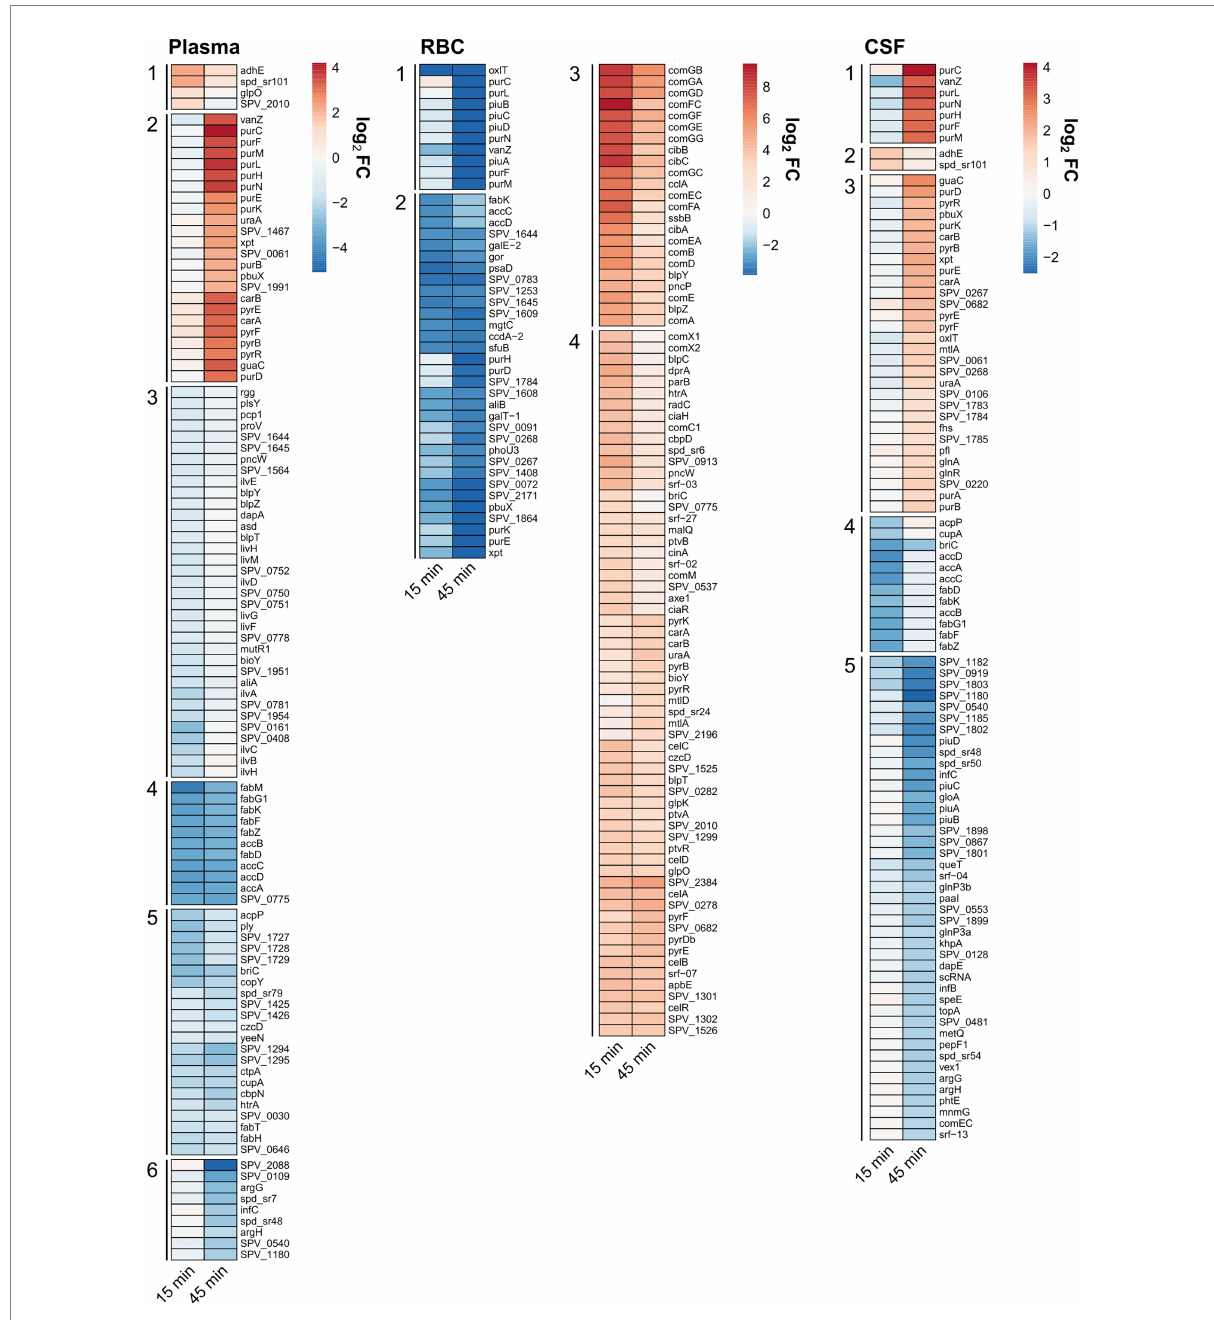
FIGURE 4 Clustered relative expression heatmaps showing the top differentially expressed genes in the different conditions: plasma, RBC and CSF cultures [FDR < 0.01, log 2 (FC) > 2 or log 2 (FC) < − 2 for plasma, log 2 (FC) > 3 or log 2 (FC) < − 3 for RBC, and log 2 (FC) > 1 or log 2 (FC) < − 1 for CSF]. Clusters with a similar expression pattern from each condition were